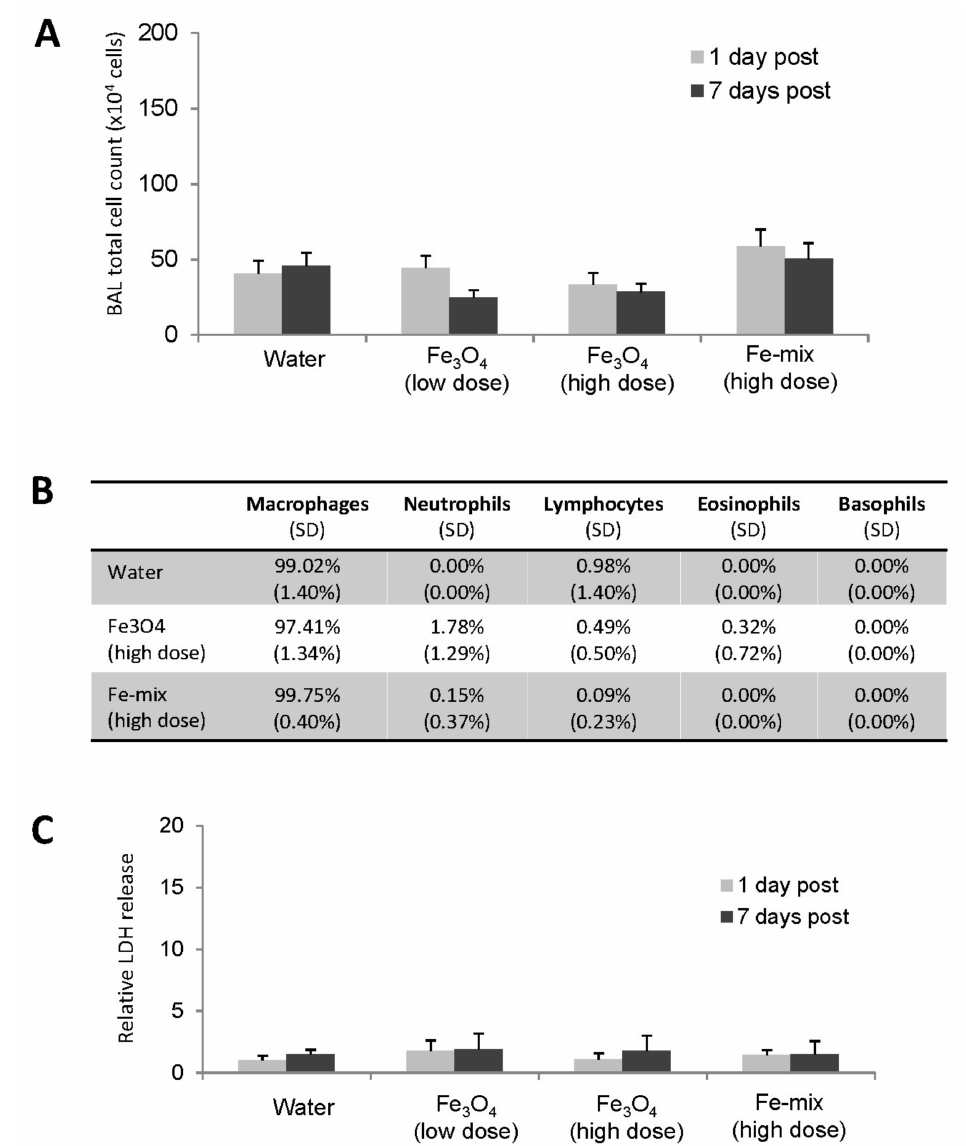
Figure 5. Cytological analysis of BALF. ( A ) Total cell counts of different exposure groups. ( B ) Cell population change at 1-day post exposure (SD values in brackets). ( C ) Gross toxicity analysis by LDH